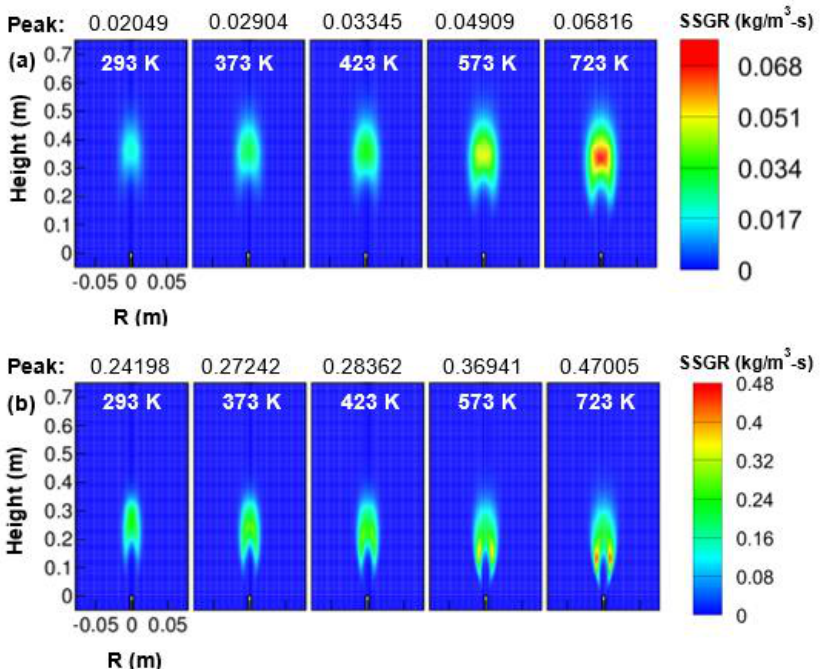
Figure 12. Soot-surface growth-rate (SSGR) contour as a function of air temperature; ( a ) 1 atm, and ( b ) 3 atm.